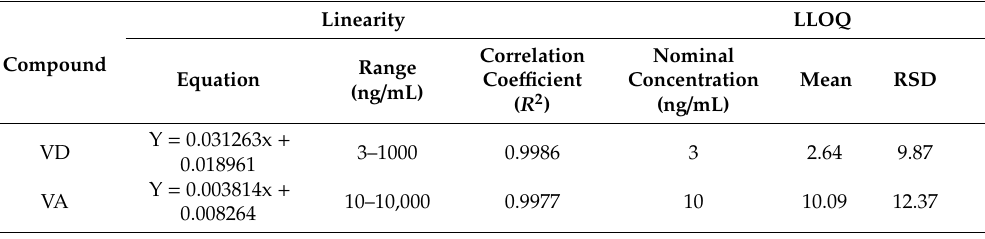
Table 2. Linearity and lower limit of quantification (LLOQ) of the LC-MS / MS method for veratraldehyde (VD) and veratric acid (VA). S / N, signal-to-noise; RSD, relative standard